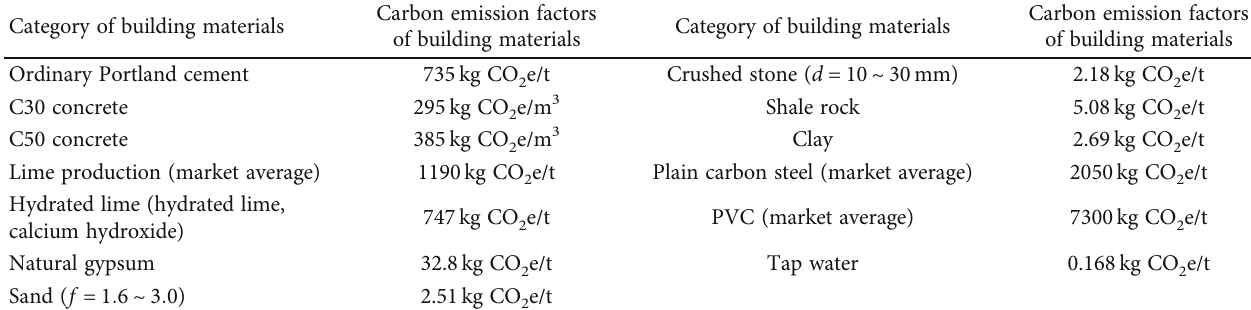
Table 3: Carbon emission factors of some building